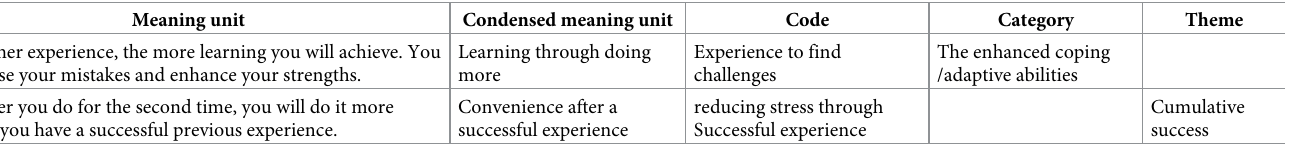
Table 1. An example of analysis process with category and